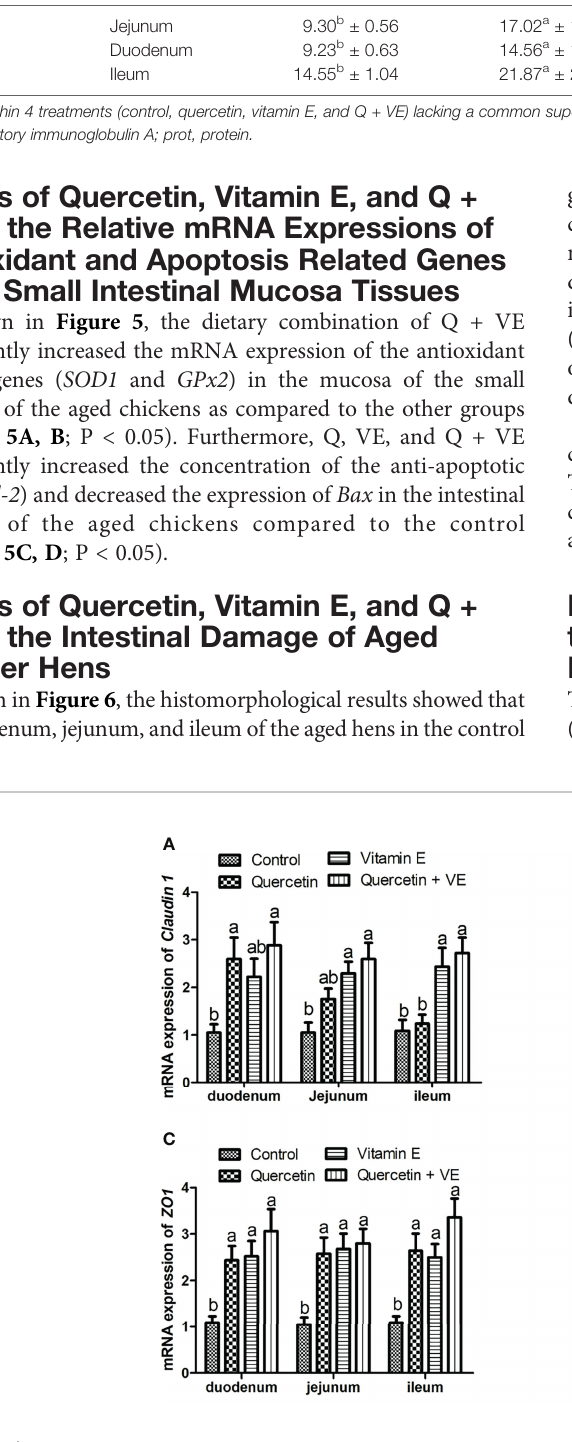
FIGURE 3 | The impacts of quercetin (Q), vitamin E (VE), and Q + VE on the mRNA expression of the tight junction proteins and barrier function biomarker genes in the small intestinal mucosa of the aged breeder hens. mRNA expression of: (A) occludin; (B) claudin 1; (C) ZO1; and (D) Mucin 2 in the small intestinal mucosa. Bars without the same letter differed signi fi cantly (P <